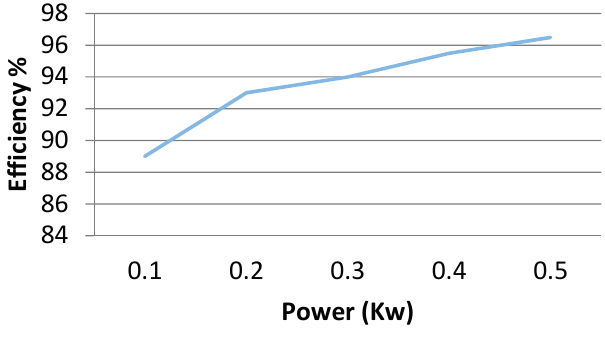
Figure 16. Efficiency tests.